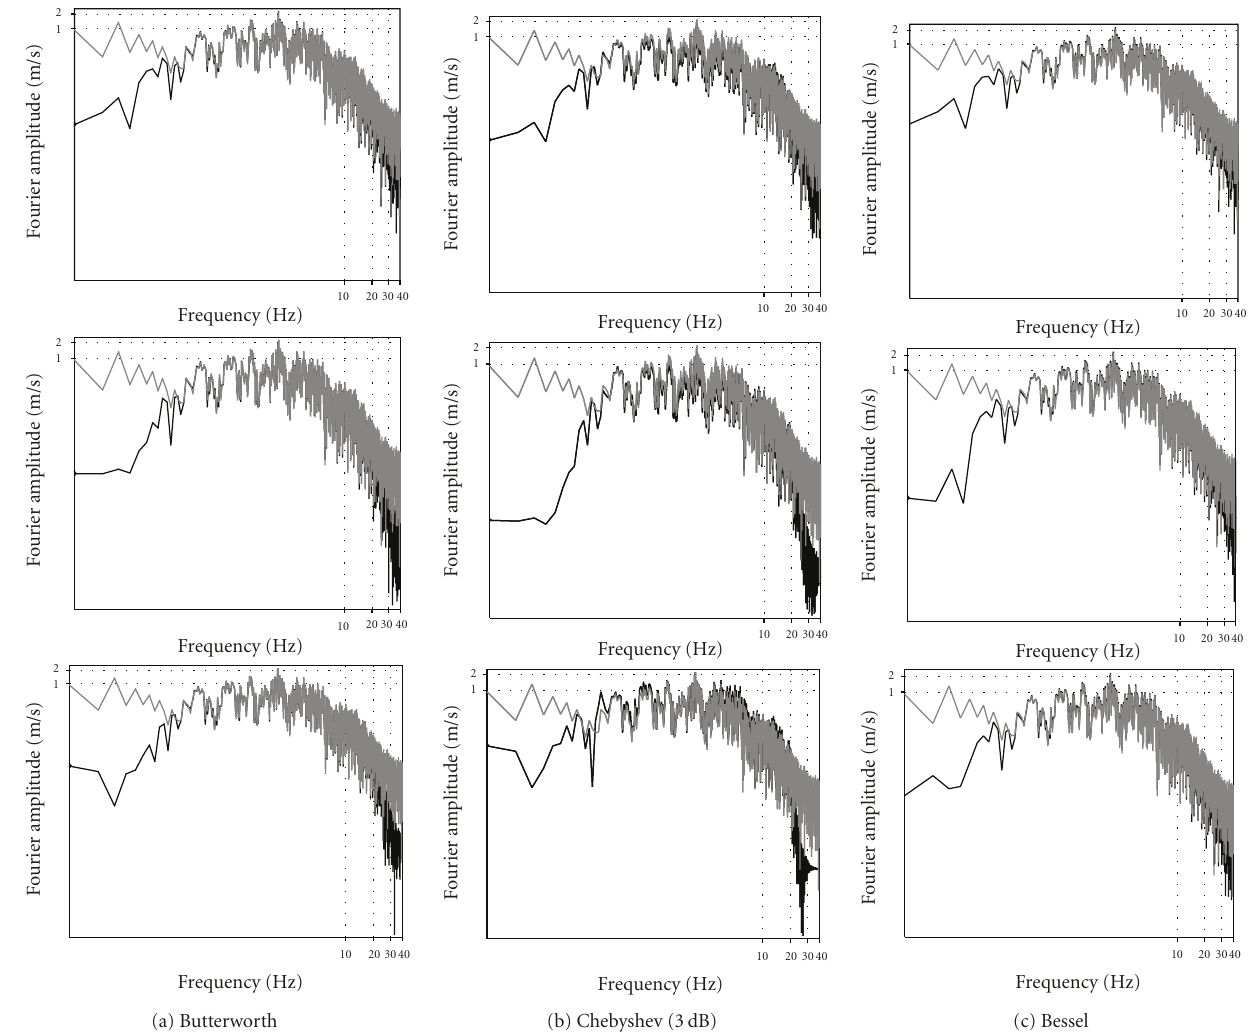
(b) Chebyshev (3dB) Figure 3: Fourier spectra of acceleration for bandpass filtered Izmit record between 0.12Hz and 20 Hz for orders N = 2, 4, and 6 (from up to down) NS component. Note: the graphics in gray color show the uncorrected